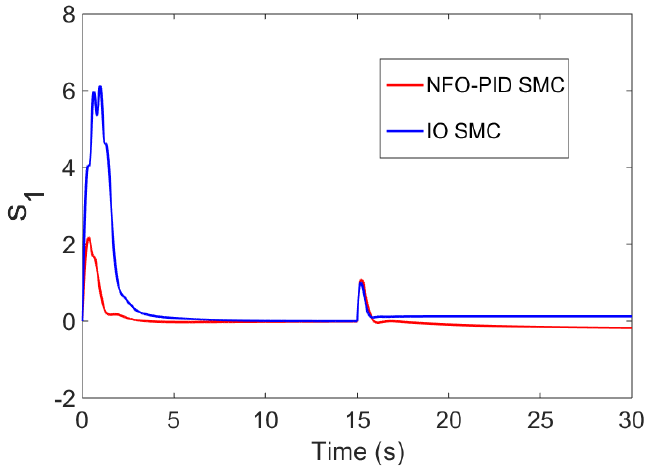
Figure 6. Curves of first-layer sliding mode surfaces s 1 .